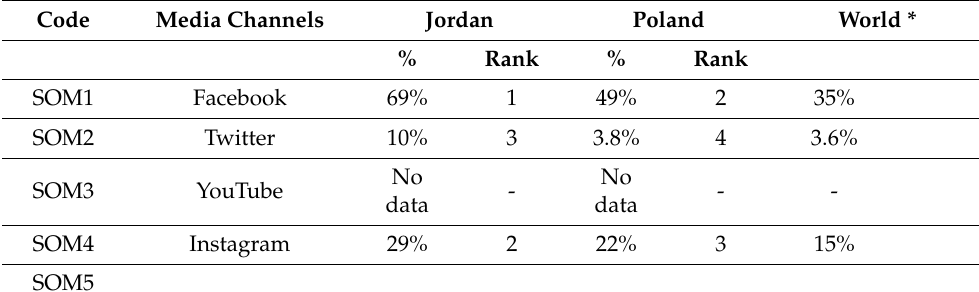
Table 12. Social media platforms’ ranking